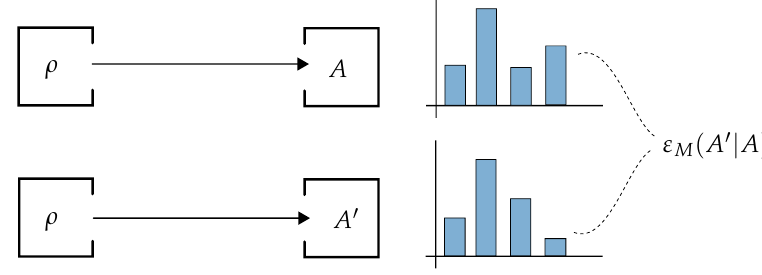
Figure 3. For the maximal measurement error ε M ( A (cid:48) | A ) the transport distance of output distributions is maximized over all input states ρ